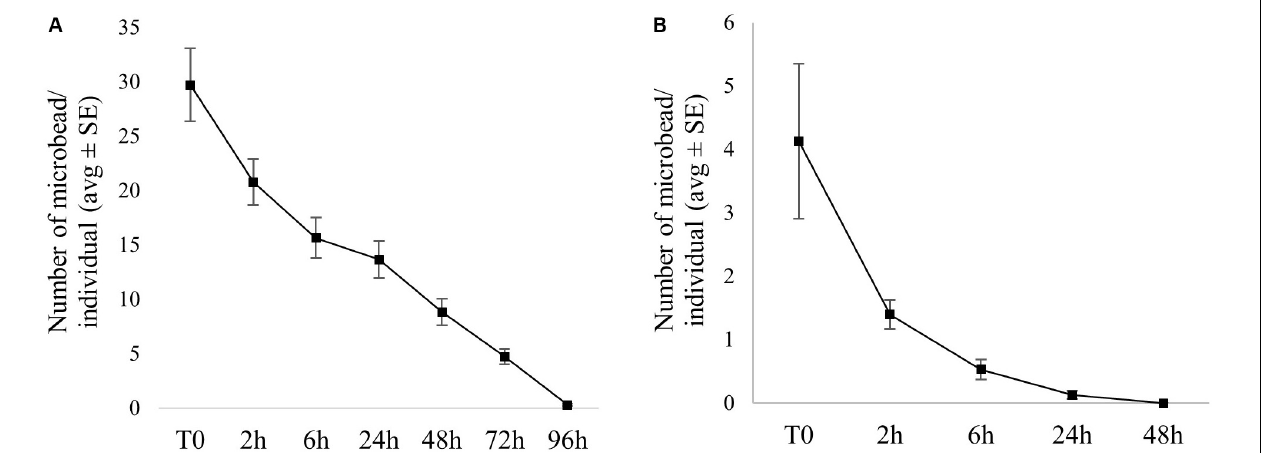
FIGURE 2 | Microbead uptake (T0) and depuration over time in Artemia exposed (A) without food and (B) in the presence of food (average number/individual ± SE).